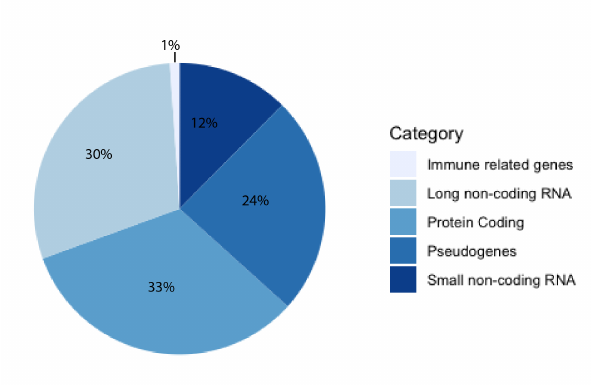
Figure 1. Pie chart of gene categories in the human genome. Data taken from GENCODE release 35.